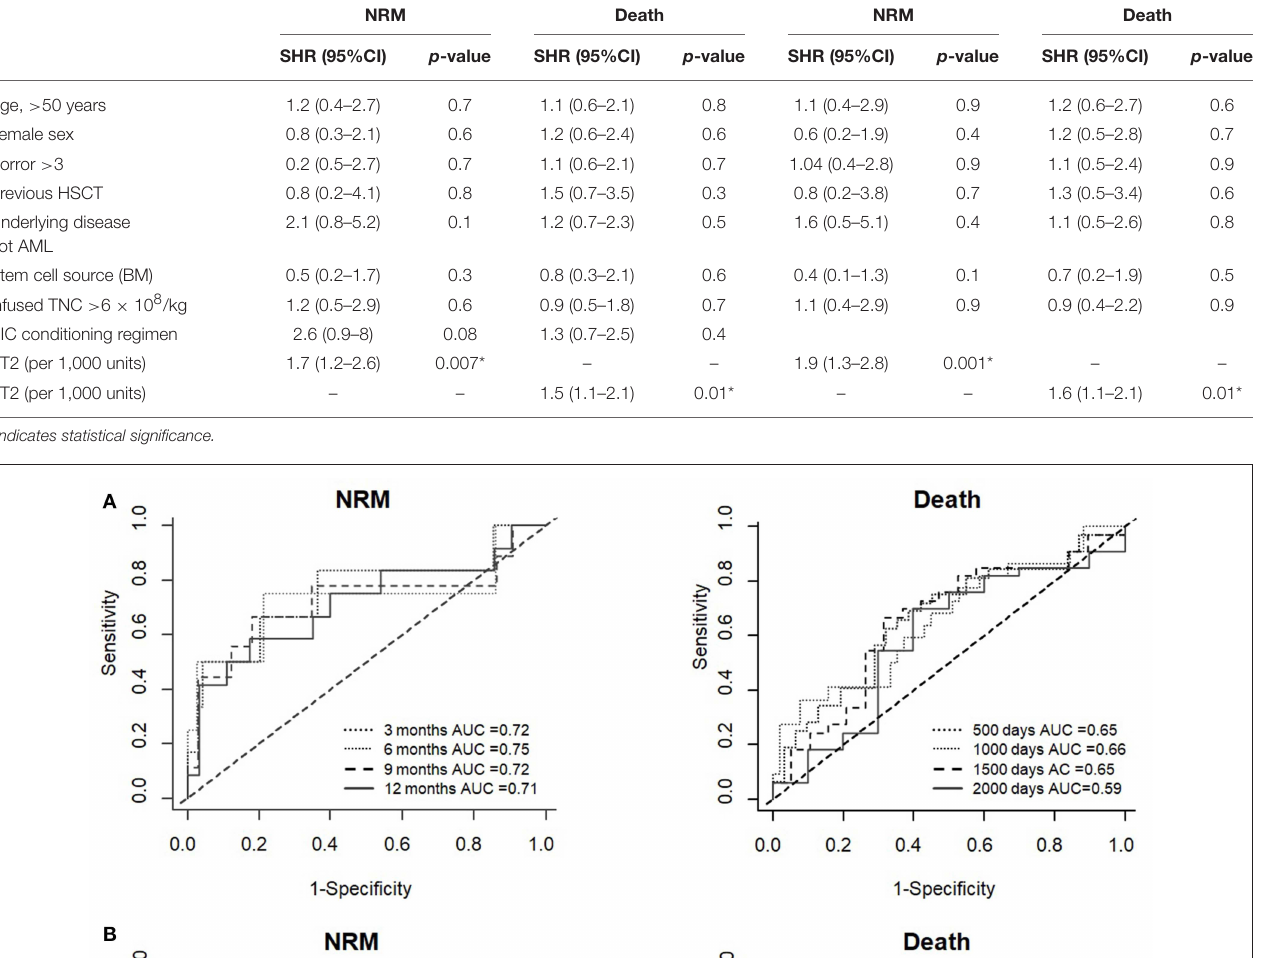
(related and unrelated) and a minority were unrelated donors. One of the studies was performed on umbilical cord blood allo-HSCT